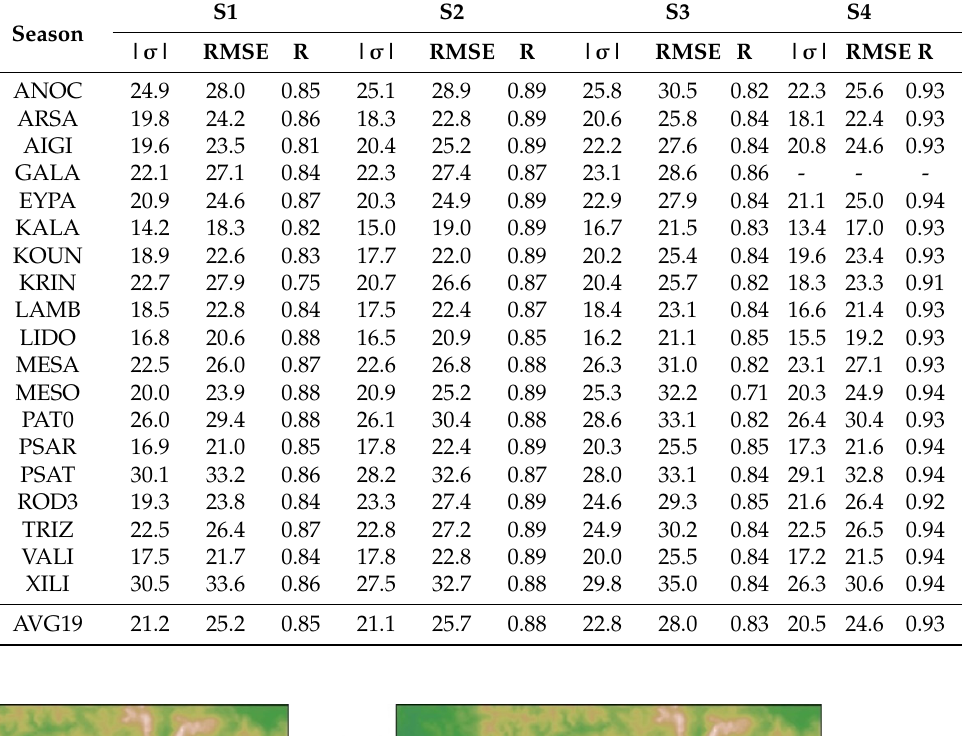
Table 5. Seasonal statistical indices of WRF ZTS vs. GNSS ZTD time series—2016.